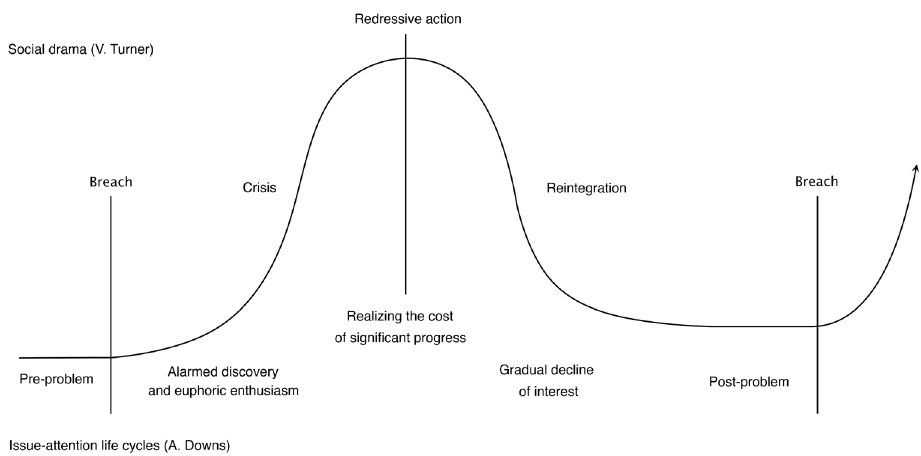
Figure 1. The scheme of a news wave and Downs’s periodization of an issue-attention cycle, which are popularly used in communication studies, depicts the quantity fluctuation in public attention. However, Turner’s periodization adds the analytic layer of the dramatic content. It can be seen from the model that the dramatic content and the public behavior correspond to a similar scheme, which constitutes the framework of the